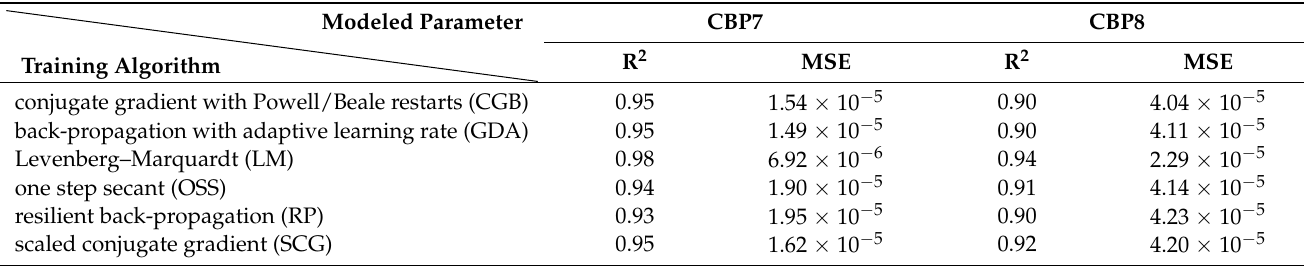
Table 8. Comparison between the performance of various ANN training algorithms for bins 7 and